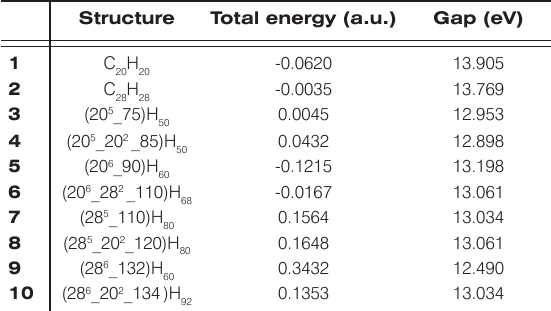
Figure 3. C Table 1. PM3 energies calculated on fully hydrogenated structures.